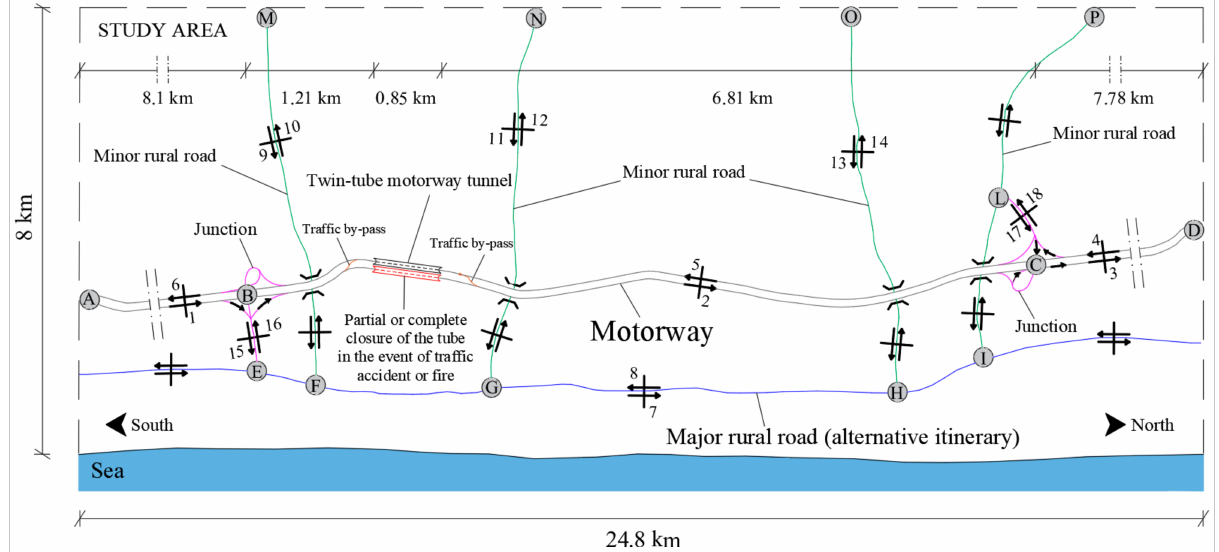
Figure 2. Schematic representation of the study area affected by a traffic accident or fire occurring in the north tube of the twin-tube motorway tunnel investigated (the image is not to